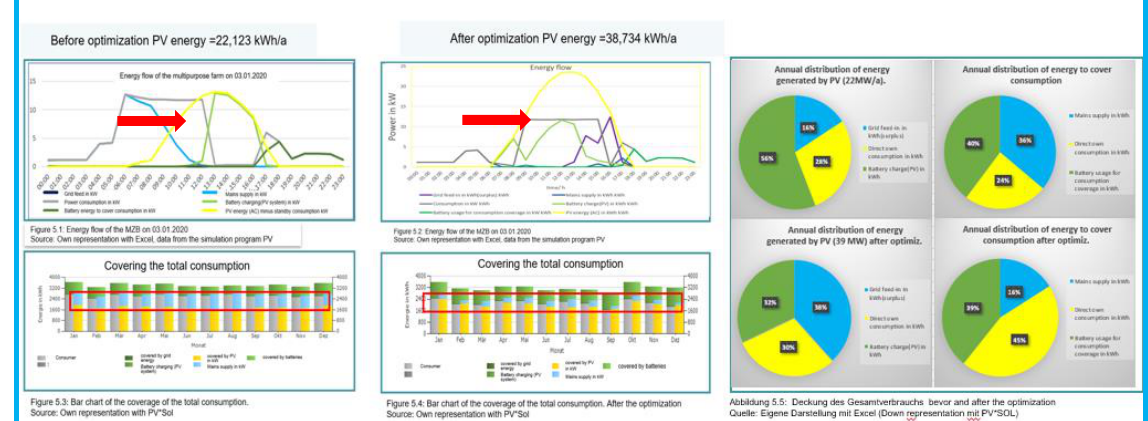
Figure 5 . Compilation of results after the